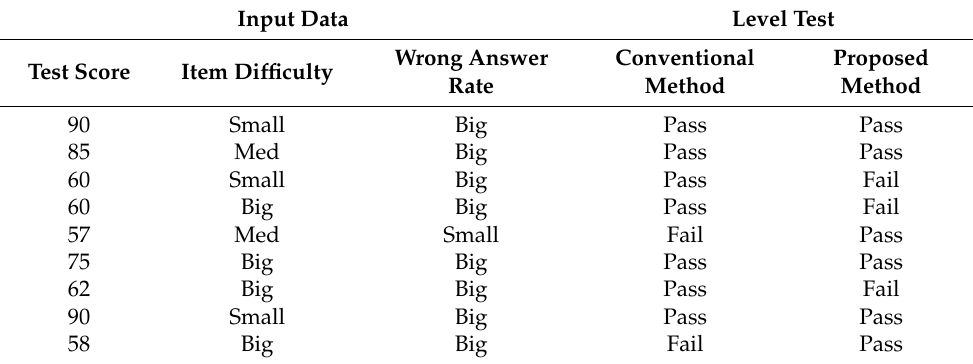
Figure 5. Flow chart of level test based on fuzzy rules. This is because even with the same 60 points, if the test difficulty is difficult, the grades change to a downward trend, so there are few high-ranking students, and low- ranking students rapidly increase. Therefore, in Figure 6, if the test difficulty is difficult